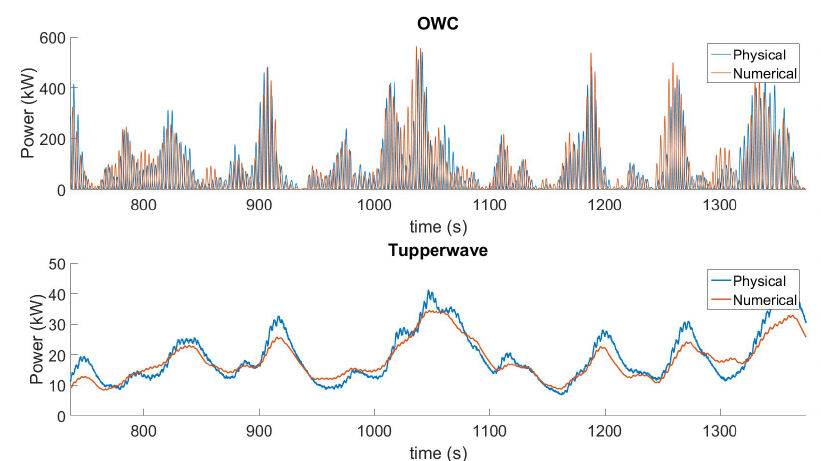
Figure 17. Pneumatic power time series for the conventional OWC and the Tupperwave device in the irregular sea state { H s = 3 m; T p = 7.1